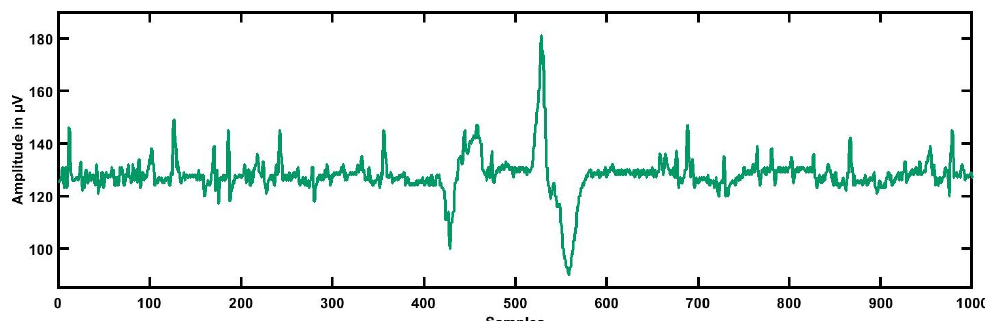
Figure 2. Typical high-risk hypertension (HRHT) myocardial infraction ECG signal.